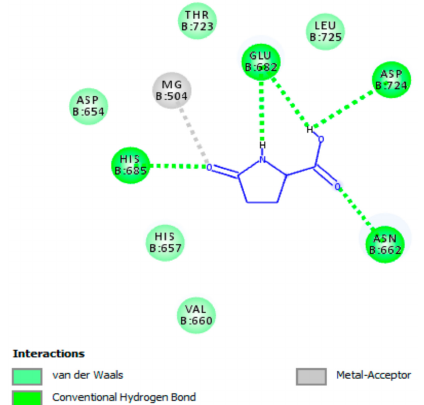
Figure 2. A two-dimensional diagram illustrates the interaction of pyroglutamic acid (pGlu) with the active site of phosphodiesterase 5A1 (PDE5A1). Essential interactions with residues of the active site that are crucial for inactivating the enzyme are presented. As shown, pGlu interacts with magnesium ion in the M site (metal-binding site) and interacts with other important residues in the L region (lid region) of the active site of the